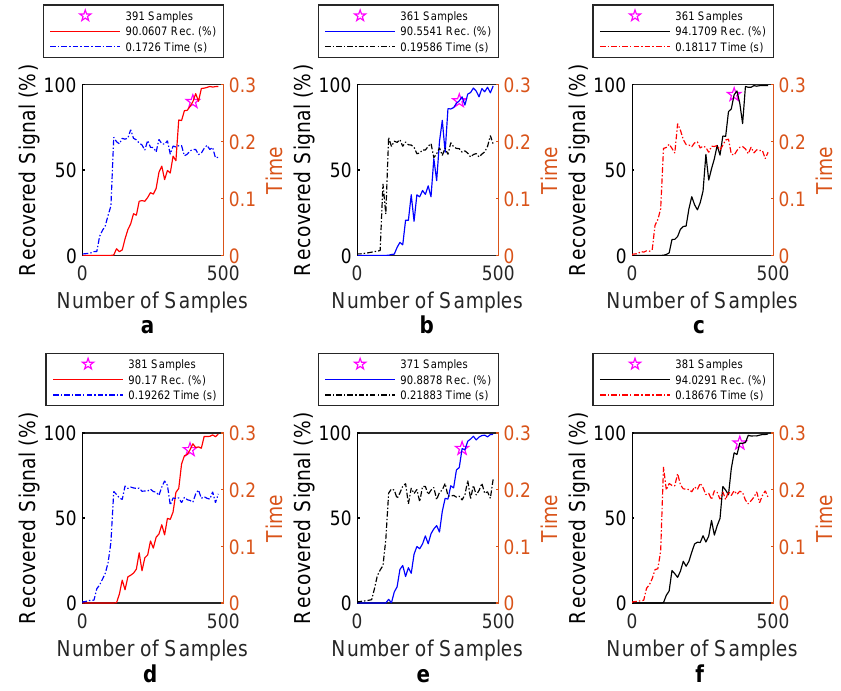
Figure 6. Number of m samples necessary to recover the original signal vs. processing time (( a – c ) current and ( d – f ) voltage at bus